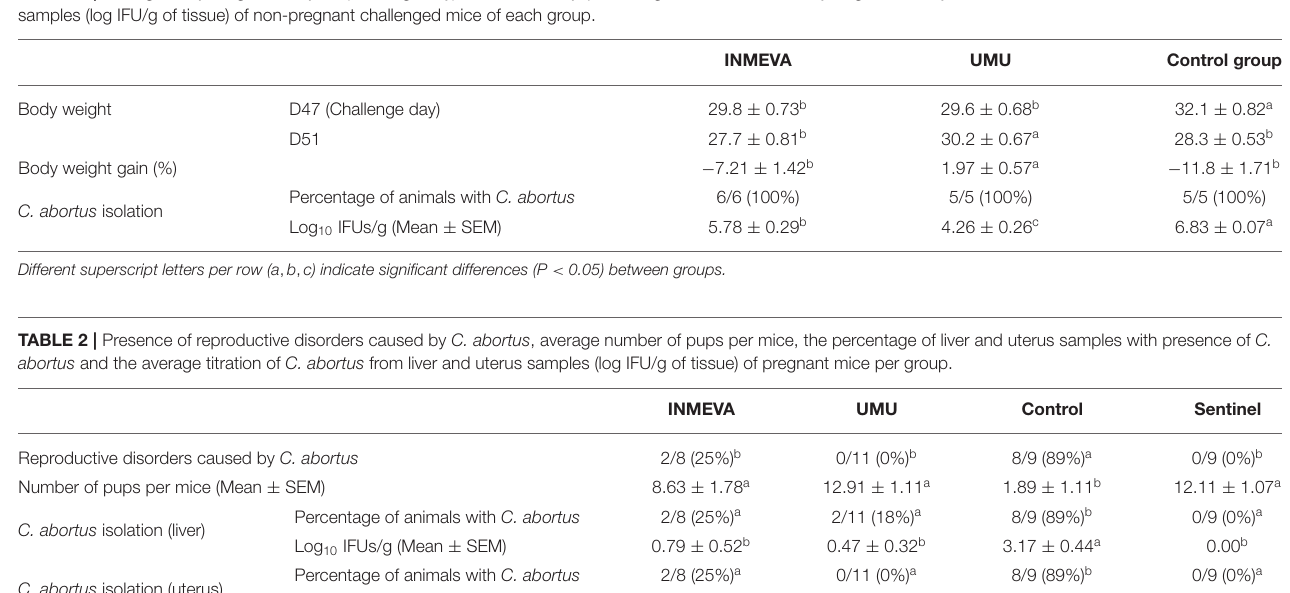
TABLE 1 | Average body weight on day 47 (challenge day) and 51 of study, percentage of difference in bodyweight from day 47 to 51 and C. abortus isolation from liver samples (log IFU/g of tissue) of non-pregnant challenged mice of each group.